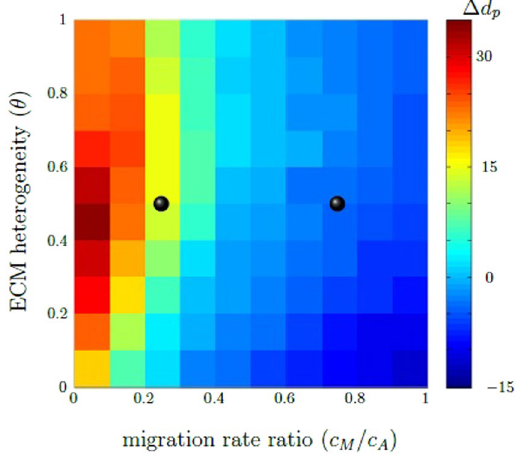
Figure 7. The difference Δ d p between the maximum average migration distance d p of switching and non- switching populations depends on the ECM heterogeneity ( θ ) and the migration rate ratio ( c c / diagram shows the difference Δ d p between the switching population with maximum average migration distance d p with respect to varied switch ratio α / β and the non-switching population with maximum average migration distance d p . Red to turquois areas indicate parameter combinations θ c c ( , / ) migration distance d p of the switching population is highest, whereas blue refers to an advantage of the non- switching behavior. The black dots illustrate points in the parameter space, which corresponds to the parameter situation of Fig. 5(a) and (b). Simulation parameters are κ = 1, δ = . 0 1